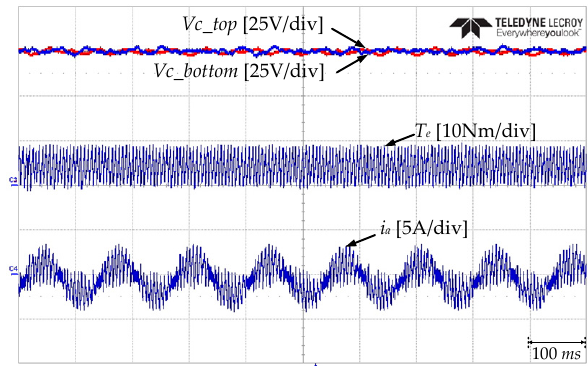
Figure 15. Experimental result of the steady-state operation under neutral-point balancing at 150 r / min.